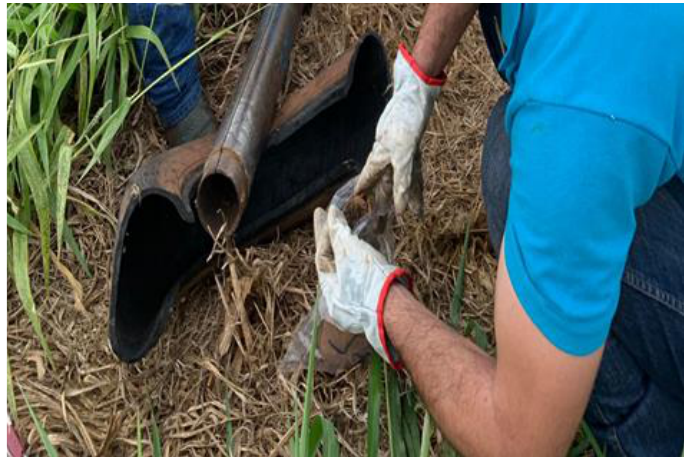
Figure 4. Root evaluation